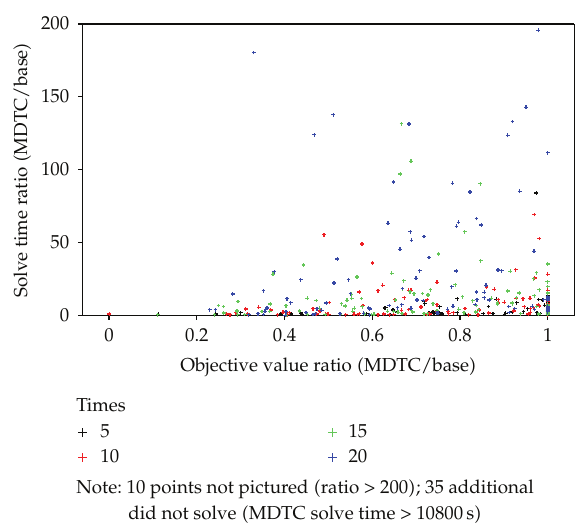
Figure 14: Comparison of MDTC/base model solve time to objective function